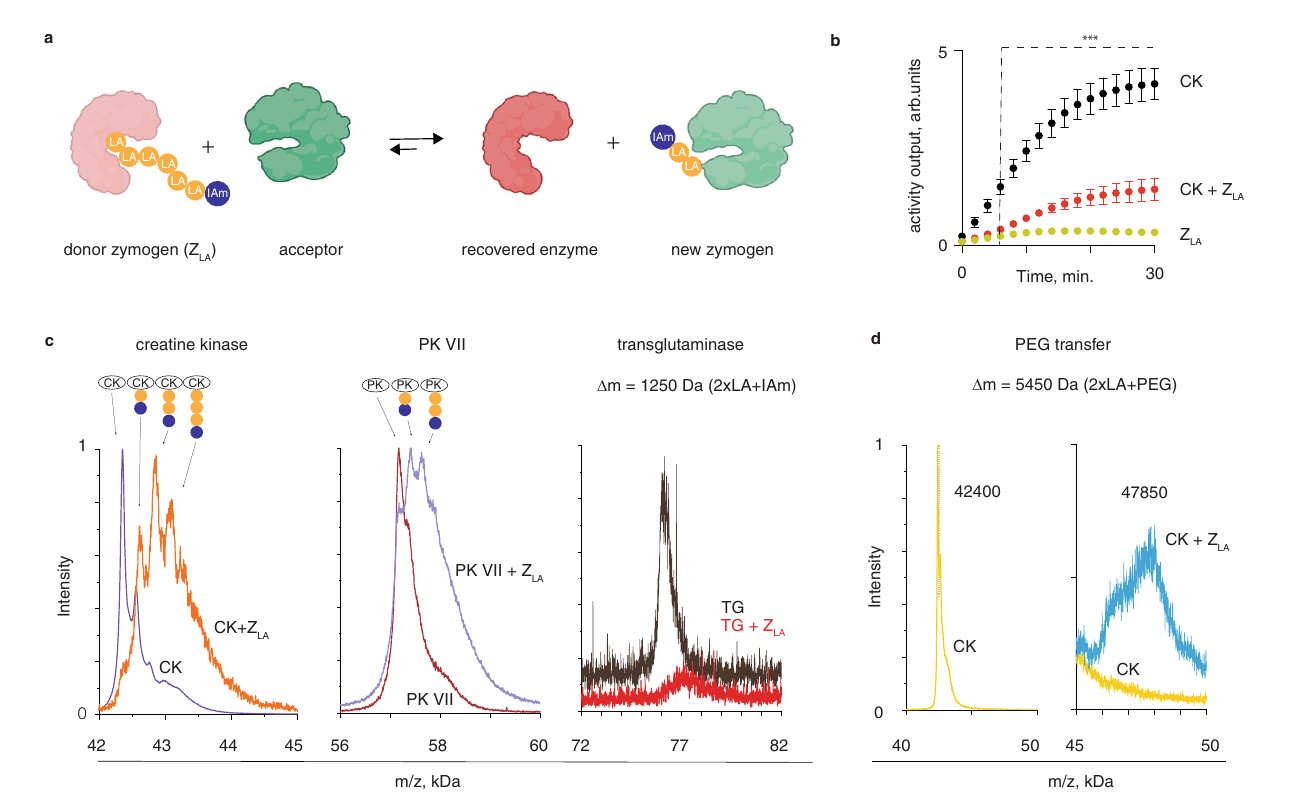
Fig. 6 | Zymogen exchange reactions. a Schematic illustration of a zymogen exchange reaction; b coupled luminescence-based read-out for activity of CK, whichillustratesalossofactivity forthekinase uponanadditionof papain Z LA asa result of the zymogen exchange reaction; shown are the results from three inde- pendentexperimentsasmean±S.D;statisticalanalysiswascarriedviathetwo-way ANOVA test with statistical signi fi cance indicating the time-point at which the